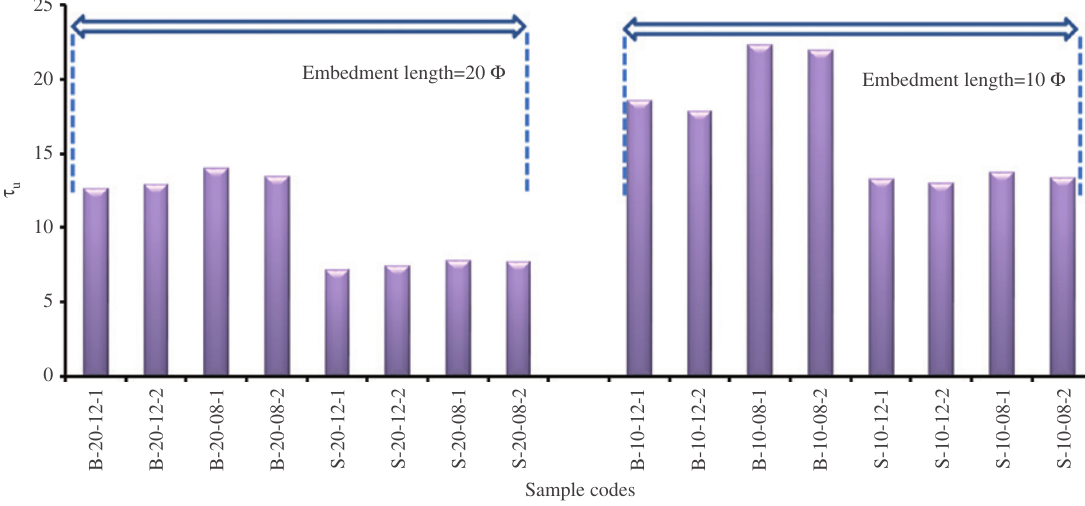
Figure 8: Maximum average bond stress values corresponding to the embedment length.